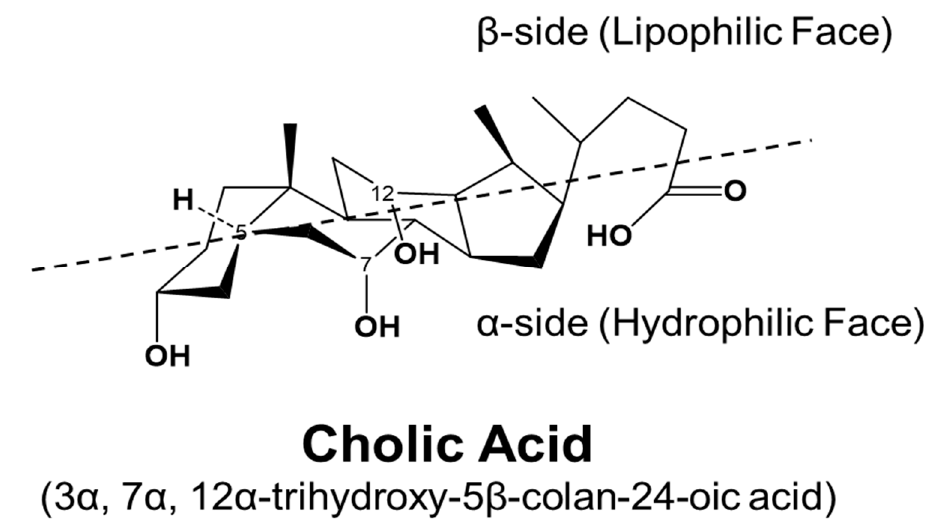
Figure 3. Stereostructure of cholic acid. The α -side forms a hydrophilic face, and the β -side forms a lipophilic face.